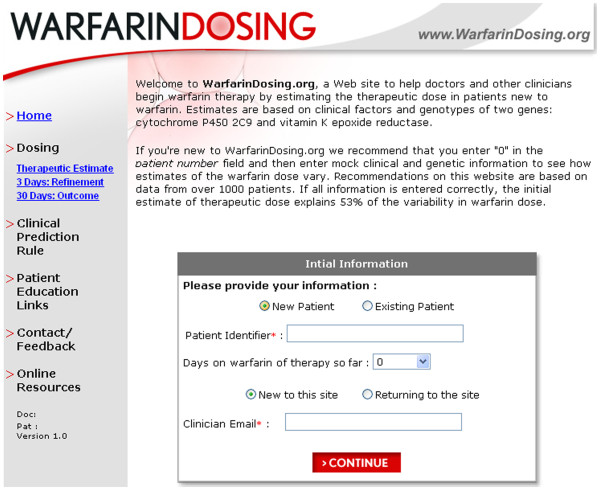
Online pharmacogenetic algorithm [65].